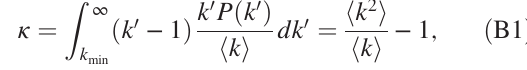
FIG. 8. Average survival time τ of a SIS epidemic on two star graphs of size k 1 ¼ k 2 ¼ k , connected by a line of r − 1 intermediate nodes, starting with only the hub of one of them in the infected state. We compare with the result for single stars of size k and 2 k . As we can see, for sufficiently small values of r (distance between the hubs), the survival time of the connected stars of size k scales with λ 2 as a single star of size 2 k